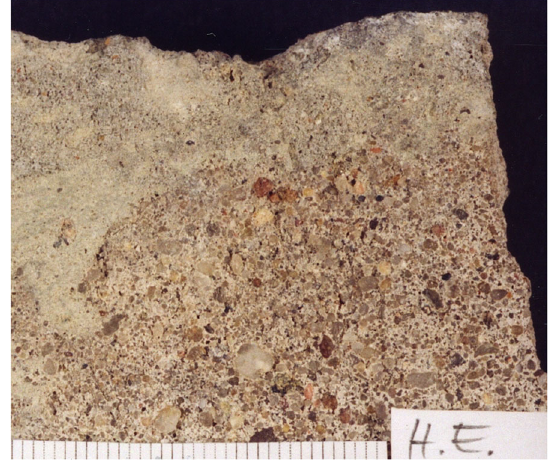
Fig. 11 Ludwig Mies van der Rohe, Berlin